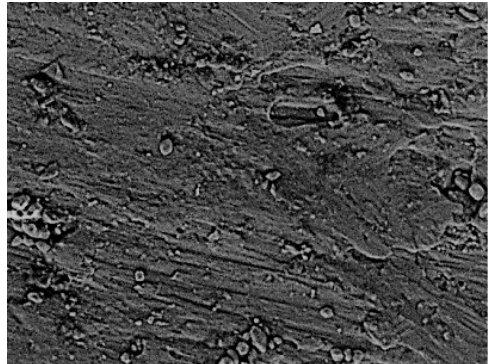
Figure 8. Corrosion rate of 4% with constant A6061 96% of NaCl-3.5%